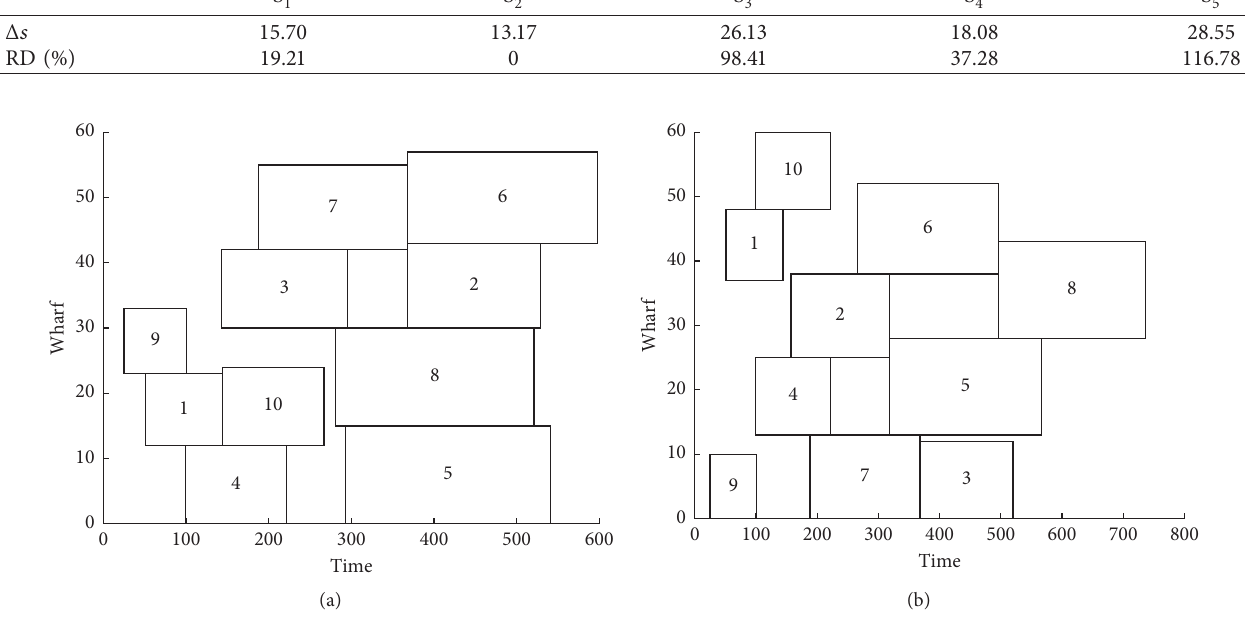
Figure 8: The (a) best and (b) worst original berth